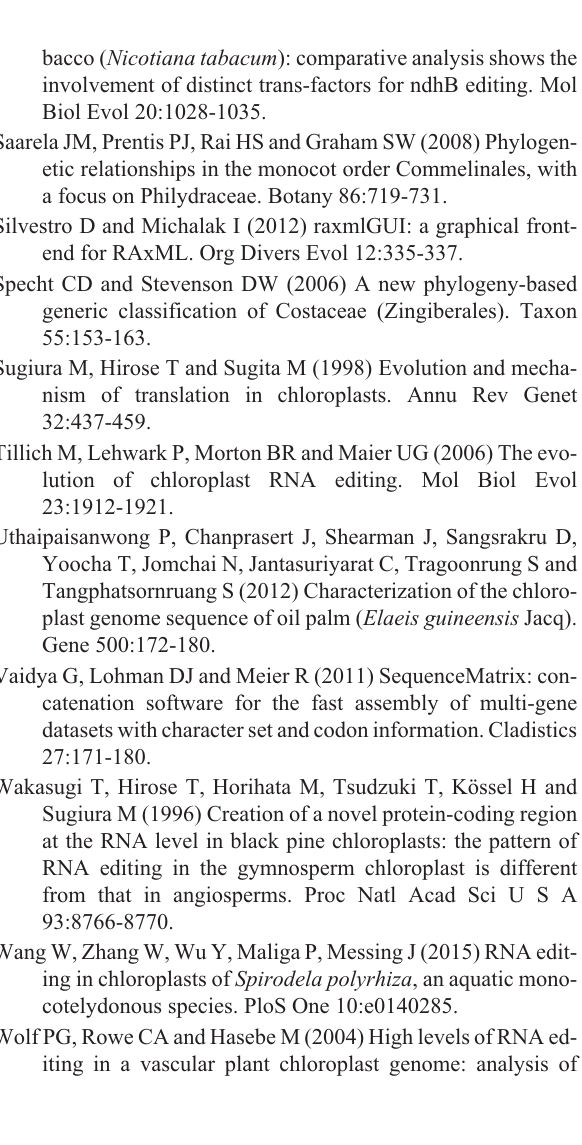
Figure S1 - Cladograms of commelinids reconstructed from 14 cp genes (without ycf1 ) based on maximum likeli- hood and Bayesian method with GTR+I+G model. Table S1 - Oligonucleotide primers for amplification of 35 cp genes. Table S2 - Comparison of RNA editing sites in chloroplast transcripts from 18 plant species. Table S3 - Accessions numbers of cp genomes from 59 plant species. Table S4 - Predicted and experimentally identified